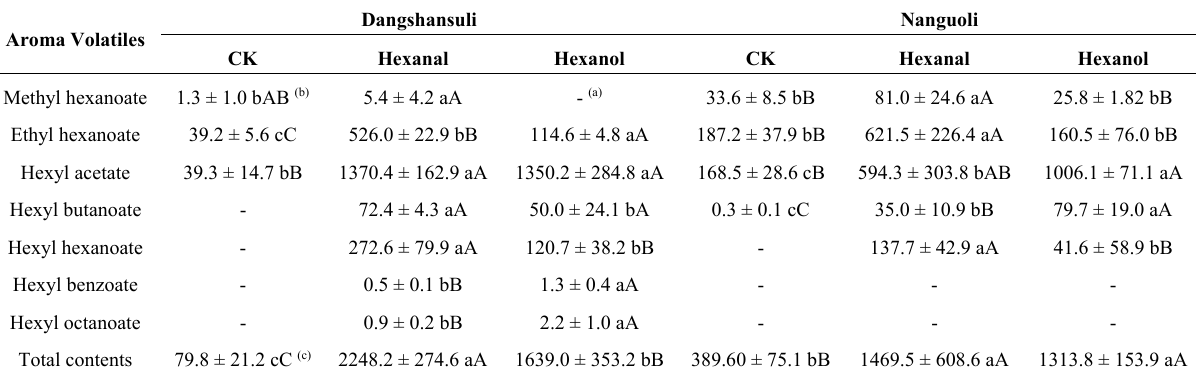
Table 3. Hexyl and hexanoate esters contents (ng·g − 1 ·FW) of pear fruits feeding on hexanol and hexanal (a) -, not detected; (b) Values represented means of three replicates; (c) Capitals denoted significant differences in a line for one cultivar at the level of 0.01. Lowercase denoted significant differences in lines for one cultivar at the level of